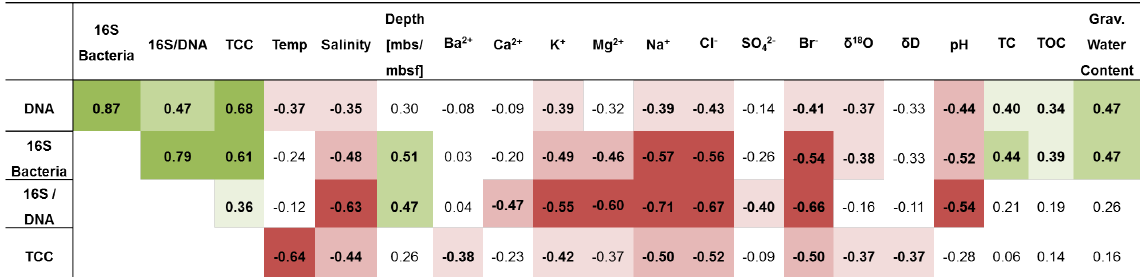
Figure 4. Box plots of microbial and bacterial abundance in Unit II. (a) Total cell counts and (b) bacterial 16S rRNA gene copy numbers normalized to gram sediment wet weight (top, solid boxes) and to DNA concentration (ng; bottom, striped boxes) of the cores C1, C4, C3, and C2. Box plots contain the mean values obtained from two technical replicates of cell counts and three technical replicates of 16S rRNA gene copy numbers per biological replicate. Median lines are indicated within the boxes in which the size corresponds to ± 25% of the data, whereas the whiskers show the minimum and maximum of all data. Minimum, maximum, and mean values, as well as standard deviation and sample numbers, can be found in Table S9. (c) Correlation of total cell counts and bacterial 16S gene copy numbers per gram of sediment. The strength of the correlation is shown in Table 1. Sample points were coloured according to drill core. Table 1. Spearman correlations of DNA concentration, 16S rRNA gene copy numbers normalized to gram sediment (16S bacteria), 16S rRNA gene copy numbers normalized to nanogram DNA (16S/DNA), and total cell count (TCC) with environmental and geochemical parameters. Presented is the correlation coefficient r s . Significant negative correlations are highlighted in red, and significant positive correlations are highlighted in green. Values in bold are significant (<0.05) when omitting p value corrections. Colour intensity represents the significance levels: from dark to light colour p <0.001, p <0.01, p <0.05. P values and more data can be found in Table